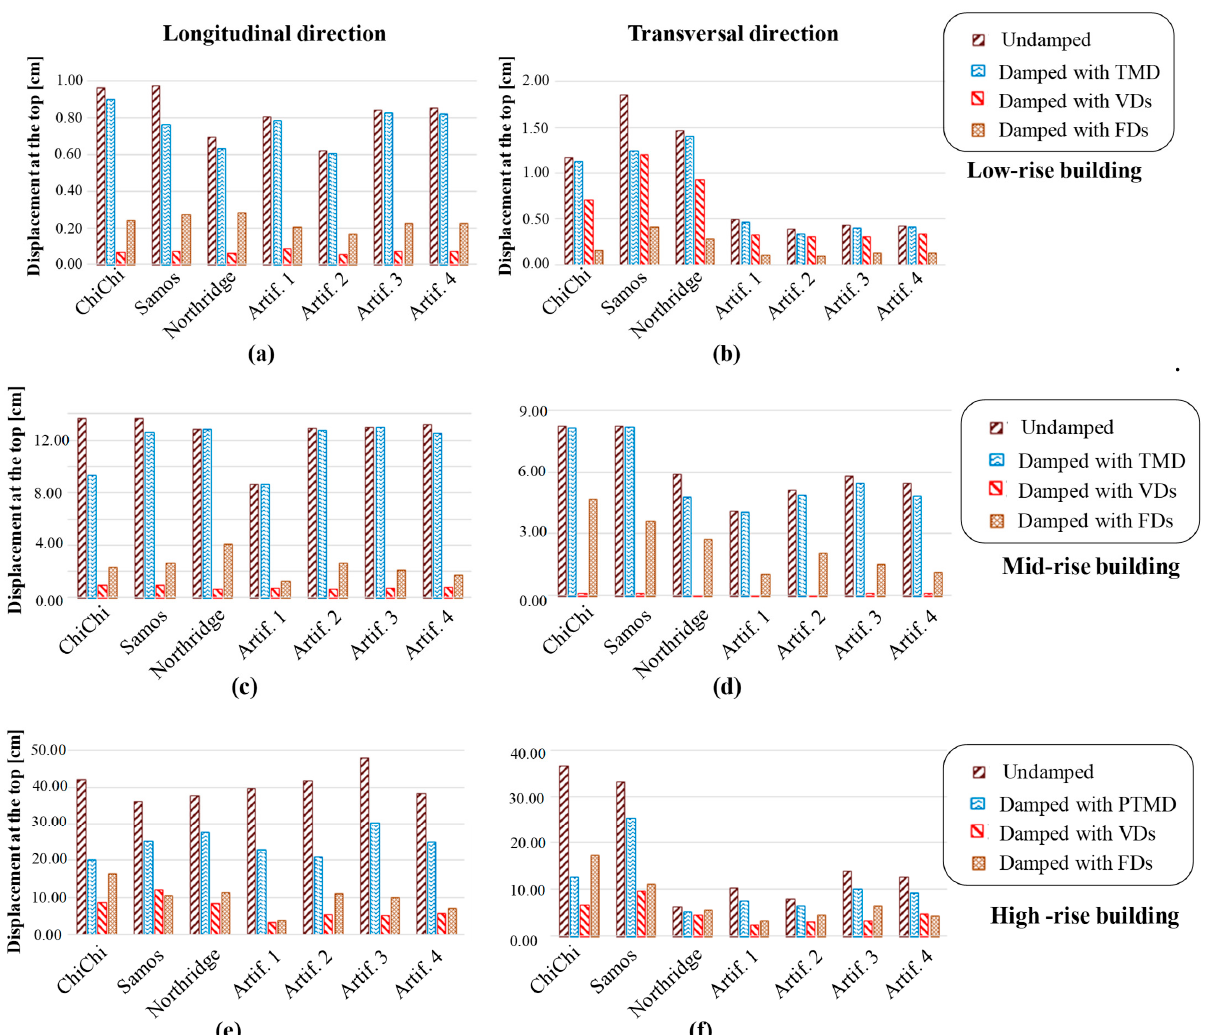
Figure 12. Horizontal displacement at the top of ( a , b ) the low-rise building, ( c , d ) the mid-rise building, and ( e , f ) the high-rise building.